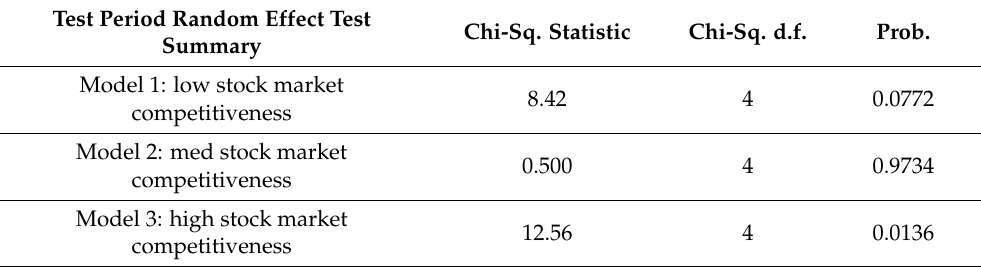
Table 3. The results for Hausman test.